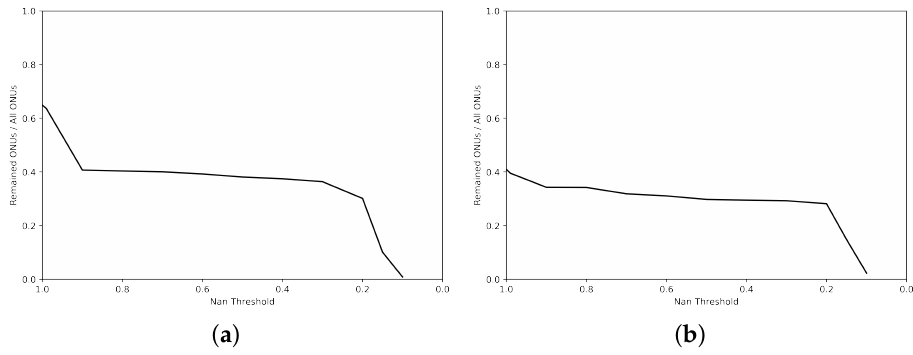
Figure A1. Relationship of filtering threshold and remaining ONUs. The horizontal axis represents the threshold. Sequences with null rates higher than the threshold will be filtered out. The vertical axis represents the number of remaining ONUs under the given threshold. ( a ) Trainset. ( b ) Testset. 1. Delete all-empty ONUs. In Figure A1, it corresponds to the situation that the threshold is 0.99. The percentage of all-empty ONUs in trainset is close to 40%, and that in testset is close to 60%. Since these ONUs do not provide any data for our experiments, deleting them is inevitable. 2. The threshold ranges from 0.99 to 0.9. On the premise of cutting sequences with a length of 1d, 0.99 is too low as a threshold, and each sequence needs only 2 valid data to meet it, which is infeasible for our model. Therefore, requiring a null ratio of less than 0.9 per sequence is a basic requirement. 3. not set the threshold that